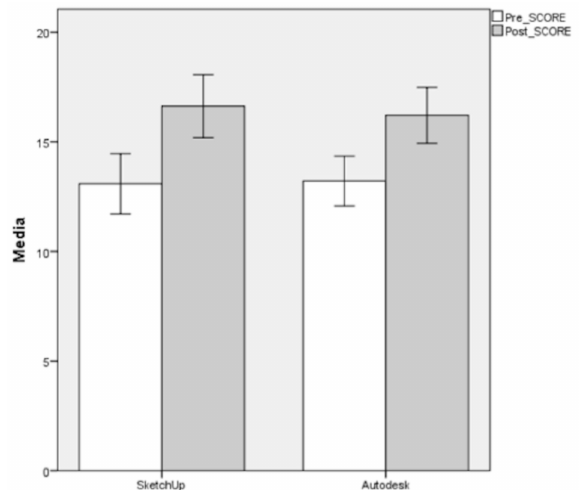
Figure 4. TMA Total Score for Pre- and Post-tests by group. Bars represent 95% confidence intervals.